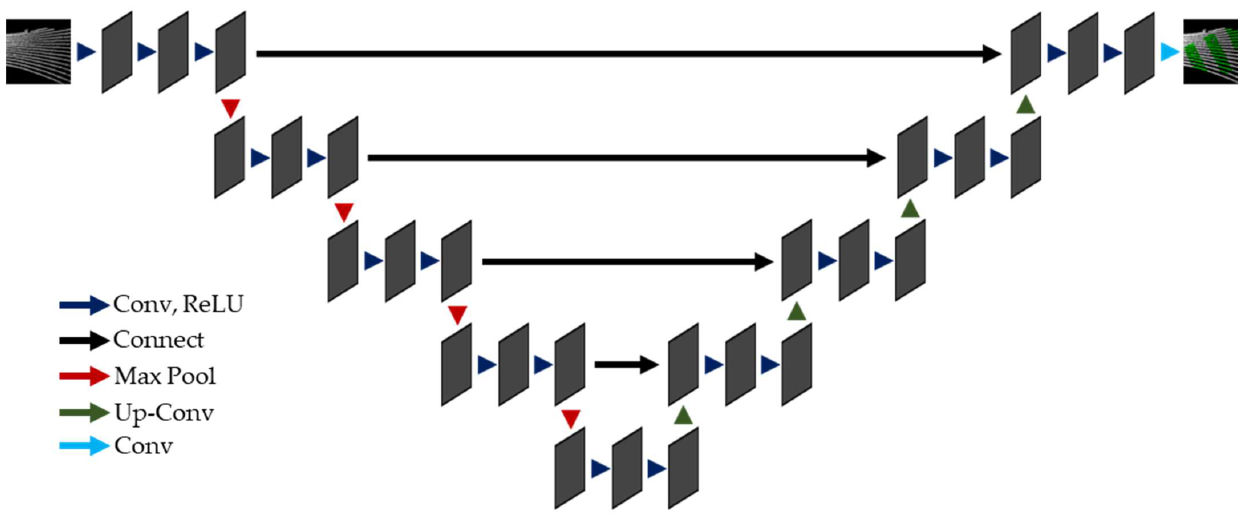
Figure 6. U-Net structure.